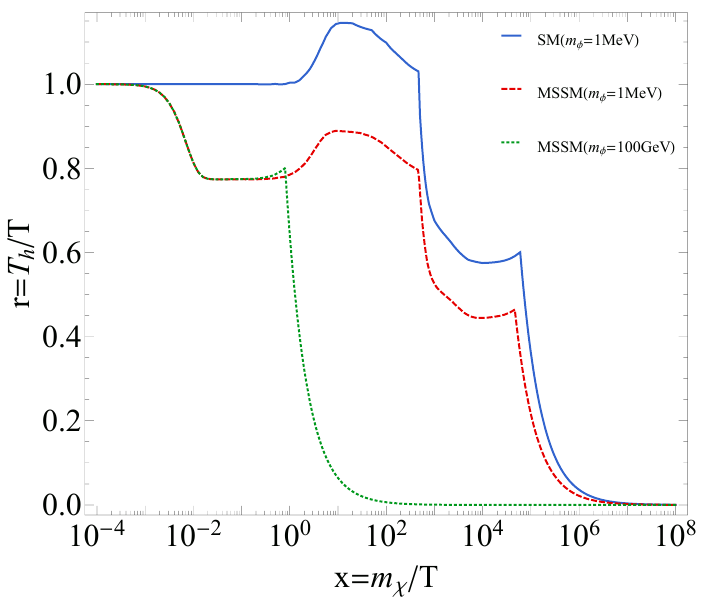
Figure 1 . Evolution of HS and VS temperature ratio r as a function of x = m χ /T for different choice of parameters. Blue solid line: the VS only consists of SM particles. Red dashed line: the VS consists of MSSM particles, all MSSM particles with the mass of 50 TeV. Green dotted line: same as the red line, but the mediator mass m